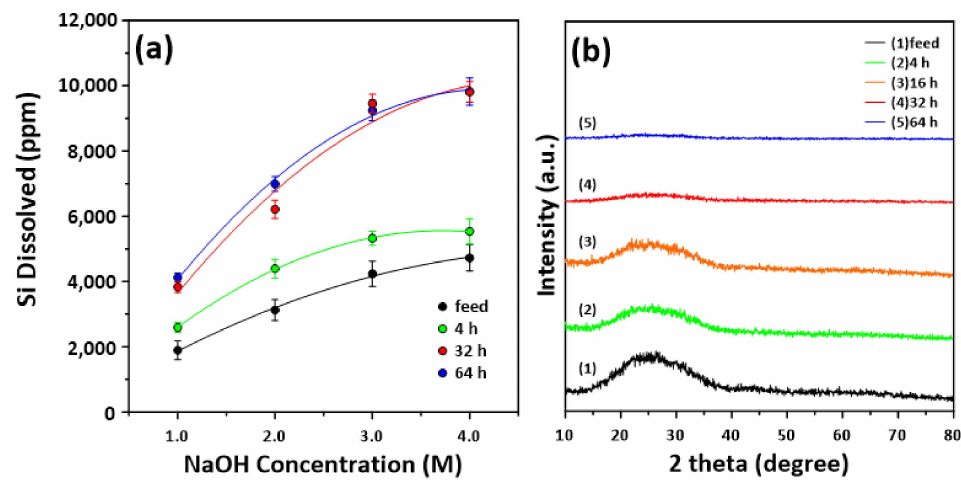
Figure 3. ( a ) Si dissolution from raw MSWI ash slag (feed) and the activated MSWI ash slag milled at 4, 32 and 64 h as a function of NaOH concentration. ( b ) XRD patterns of raw MSWI ash slag and activated MSWI ash slag milled at 4, 16, 32 and 64